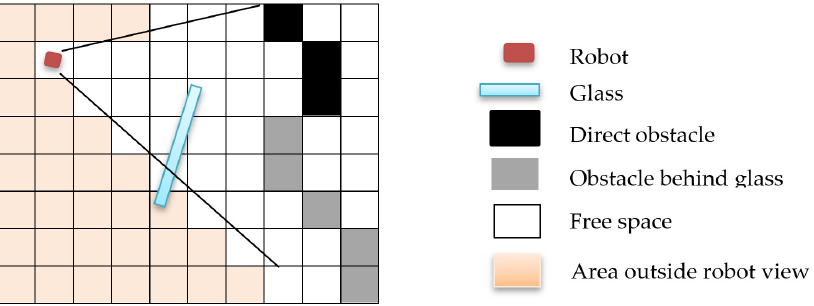
Figure 1. Illustration of a conventional occupancy map in a glass environment.